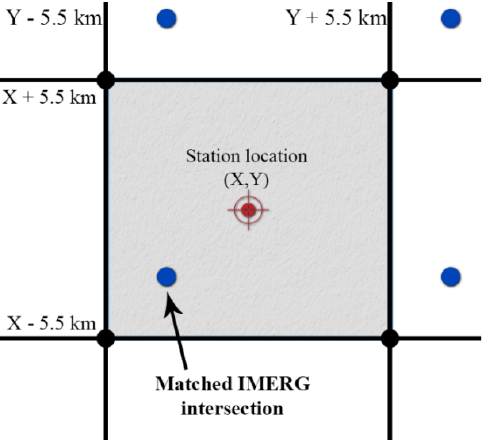
Figure 4. Coordinate-matching process layout. Table 1. Statistical measures used for evaluating IMERG